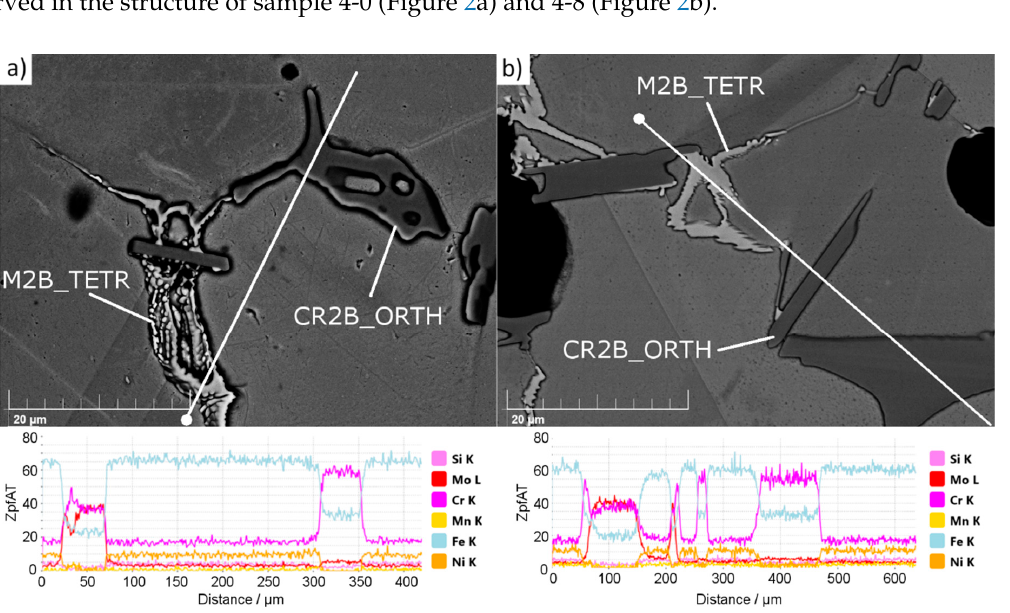
(ii) M 2 B with a tetragonal crystallographic structure. At room temperature, their molar fraction in the